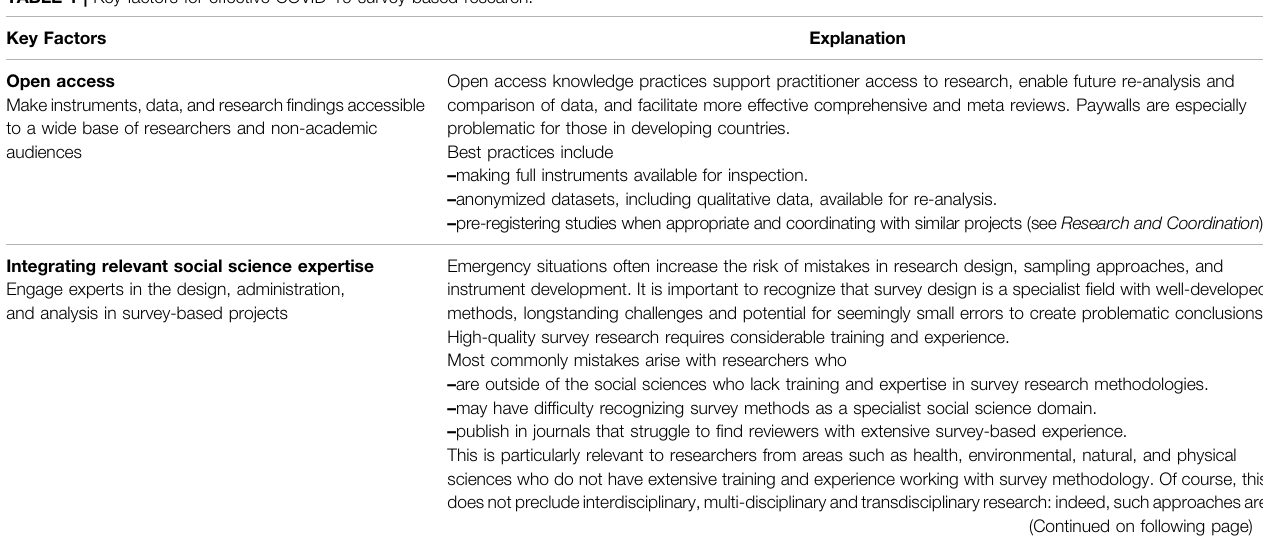
TABLE 1 | Key factors for effective COVID-19 survey-based